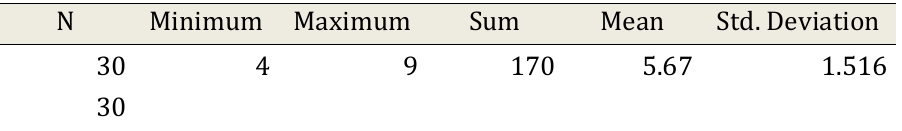
Table 4.25. Mean score pretest of Students' in Control Class Statistic Descriptive